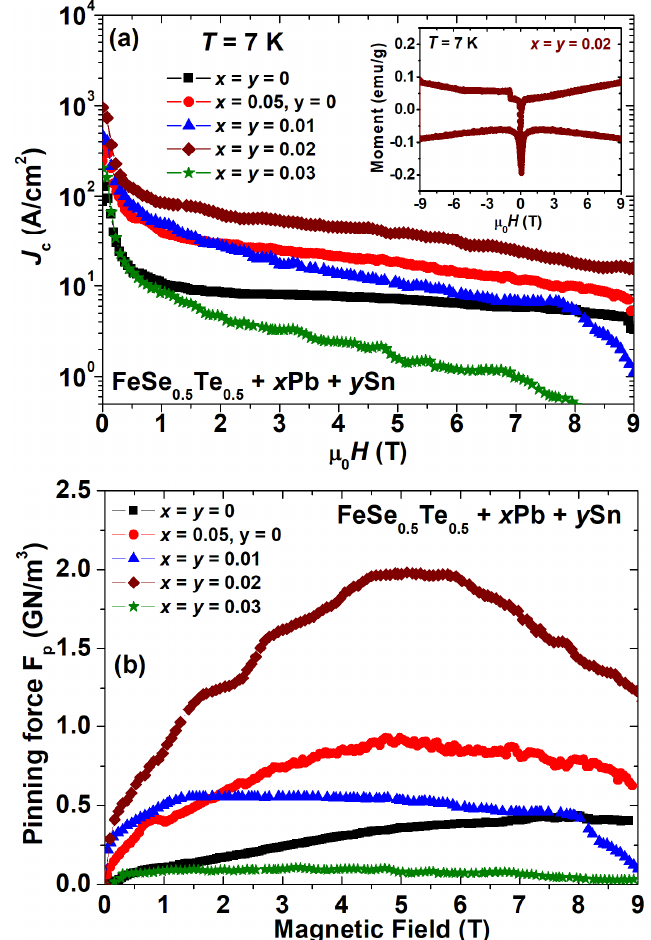
Figure 5. ( a ) The magnetic fi eld ( H ) dependence of critical current density ( J c ) for FeSe 0.5 Te 0.5 + x Pb + y Sn ( x = y = 0, 0.01, 0.02, 0.03, and x = 0.05, y = 0)) samples with respect to the parent compound FeSe 0.5 Te 0.5 at a temperature of 7 K. The inset fi gure shows the magnetic hysteresis loop M ( H ) at 7 K for x = y = 0.02 after the subtraction of the normal state background. ( b ) The variation of pinning force F p with respect to the applied magnetic fi eld at 7 K for various bulk FeSe 0.5 Te 0.5 + x Pb + y Sn ( x = y = 0, 0.01, 0.02, 0.03, and x = 0.05, y = 0)) samples.